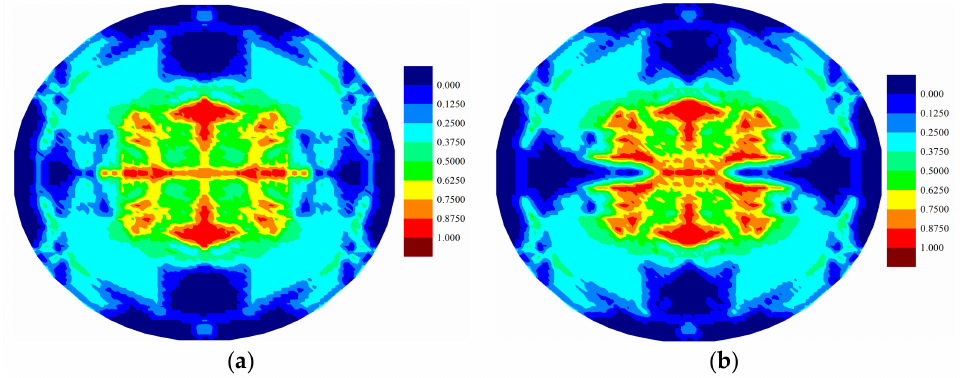
Figure 14. Matrix damage comparison of bottom ply for ( a ) coupled case and ( b ) uncoupled case at 0.28453 × 10 − 3